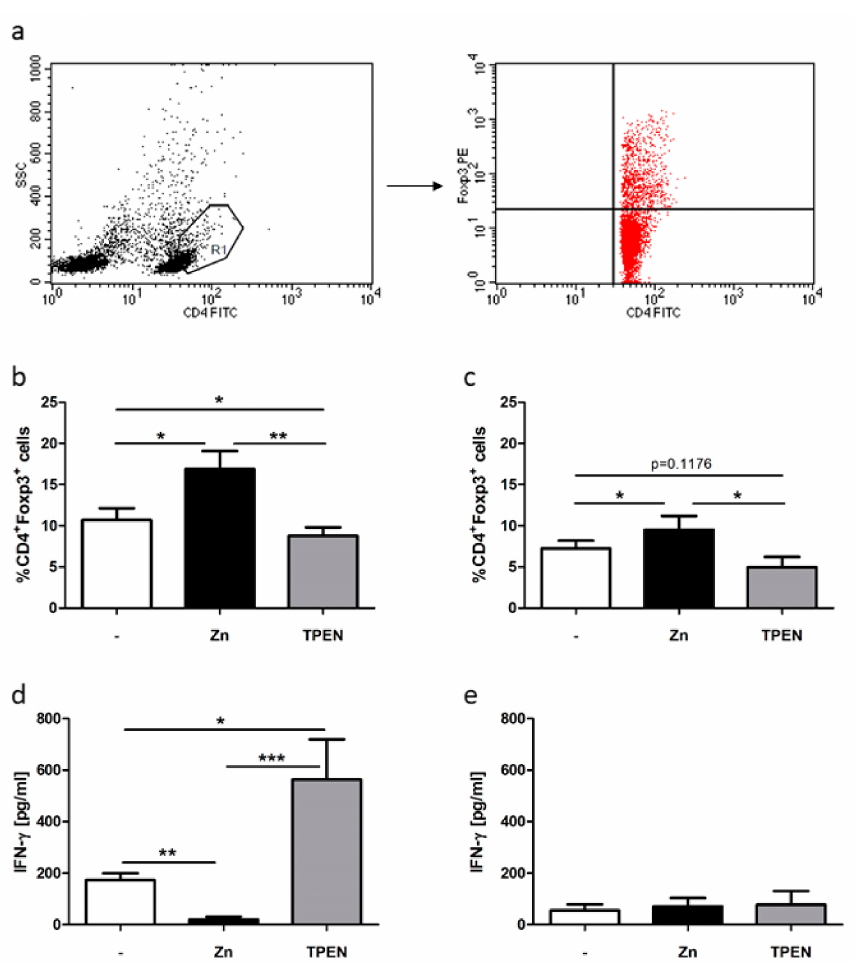
Figure 2. Zinc deficiency and zinc supplementation adversely influenced Treg differentiation in MLCs. Here, 2 × 10 6 PBMCs/mL remained untreated or were pre-incubated with 50 µ M zinc (black bars) or 1.5 µ M N,N,N (cid:48) ,N (cid:48) -Tetrakis(2-pyridylmethyl)ethylenediamine (TPEN) (grey bars) for 15 min. MLCs were generated for five days. ( a ) One representative dot blot of gated (polygon, R1) viable CD4 + activated T cell blasts is displayed showing side scatter (SSC) and CD4-FITC (fluoresceinisothiocyanat) staining. Gating procedure was established in reference [16]. ( b ) Only cells of R1 (red dots) are displayed and were analyzed regarding CD4-FITC and FOXP3-PE (phycoerythrin) staining. These Tregs were calculated using FACS analysis in MLCs (activated T cells) and ( c ) PBMCs (resting T cells). The concentration of the pro-inflammatory cytokine interferon (IFN)- γ was measured in ( d ) MLCs and ( e ) PBMCs. All data are shown as means + SEM of n = 6 independent experiments (* p < 0.05, ** p < 0.01, *** p < 0.001, Student’s t